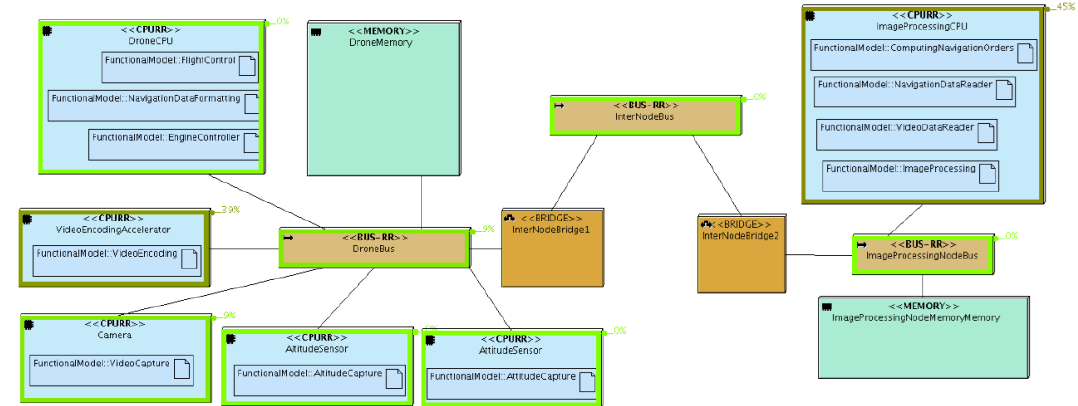
Figure 6: Placement of functions and load analysis for the drone